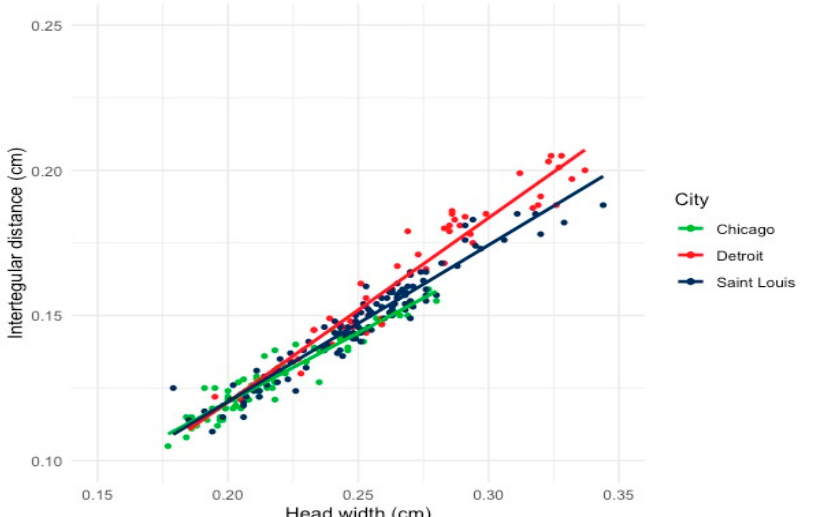
Figure 3. Variation in body size of H. ligatus females from three Midwestern cities: Chicago, Detroit, and St. Louis. The spread of body size variation was greatest in Detroit. Additionally, the bee with the largest head width was located in Saint Louis (0.337 cm) and the bee with the smallest head width was sampled from Chicago (0.177 cm). Table 1. Results of a Tukey HSD post hoc analysis reveal significant differences between the variation of body size of Halictus ligatus females in Detroit, Chicago, and Saint